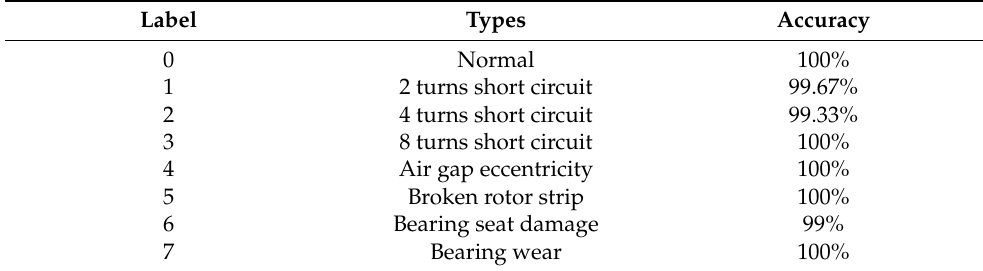
Table 3. The result of each category of fault identification.